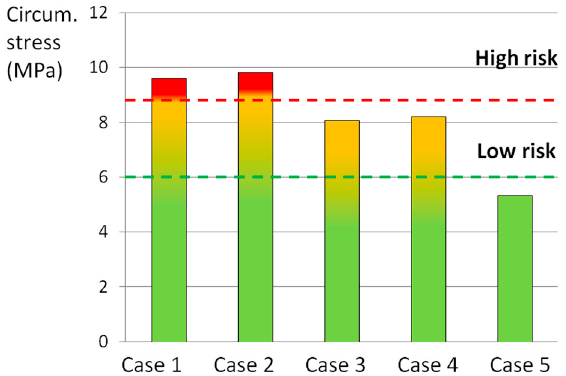
Figure 5. Average tensile circumferential (Circum.) stress generated by the loading cases listed in Table 1 in POST-LAT1 section. The red and the green lines indicated the thresholds identified as “high risk” and “low risk” of failure, respectively.